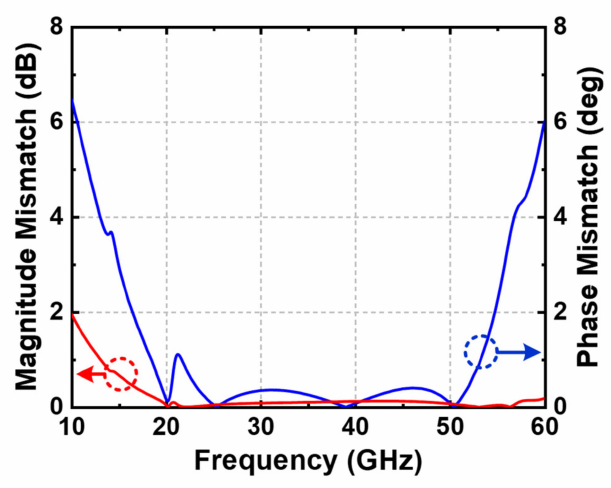
Figure 14. Magnitude (red line) and phase (blue line) mismatch of the proposed ultra-wideband I/Q signal generation